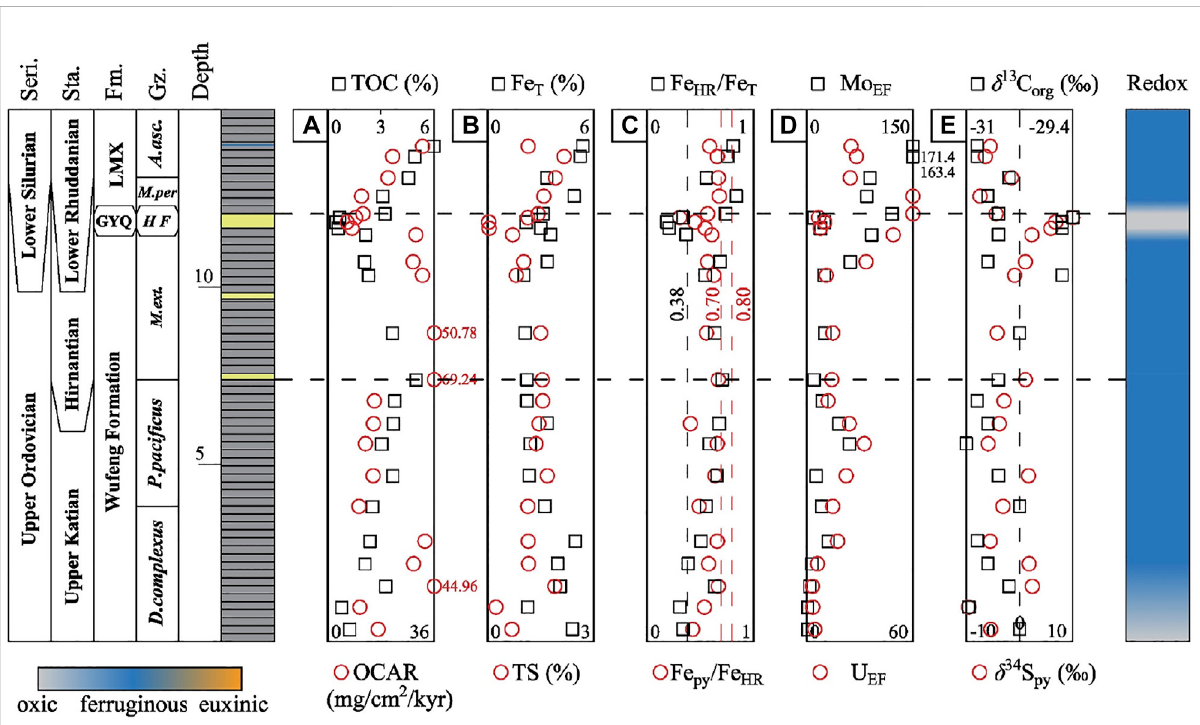
FIGURE 2 Chemo-stratigraphic pro fi les of (A) TOC and OCAR, (B) Fe T and TS, (C) Fe HR /Fe T and Fe py /Fe HR , (D) Mo EF and U EF , (E) δ 13 C org and δ 34 S py , and a redox summary for the Tianlin section. Vertical dotted lines represent the threshold for each